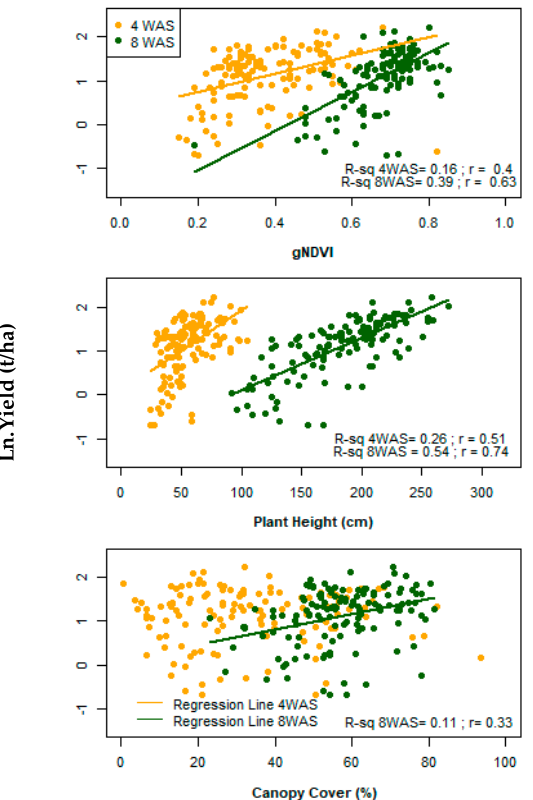
Figure 4. Linear relationship between maize grain yield and measured normalized di ff erence vegetation index (gNDVI), plant height, and canopy cover percentage measured on nutrient omission trials (NOTs) within smallholder maize farms in Nigeria. Regression lines are included for only significant relationshipsand assessed by the coe ffi cient of determination, R-sq (at significance level, α , = 0.05); WAS denotes Weeks after Sowing.